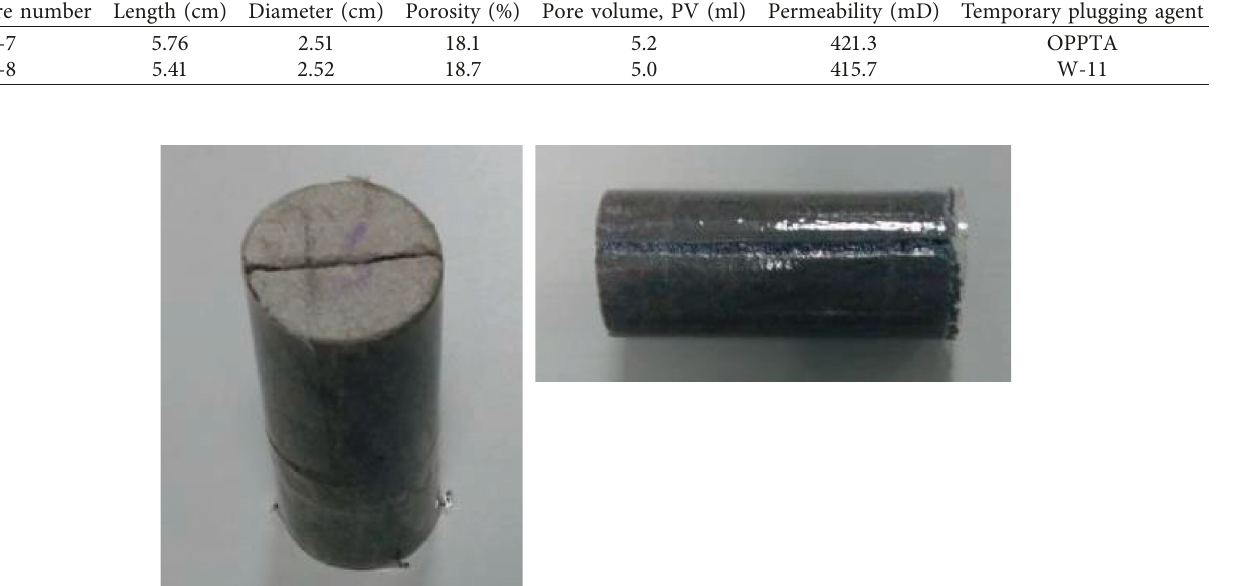
Figure 1: The natural cores with the artificial fracture